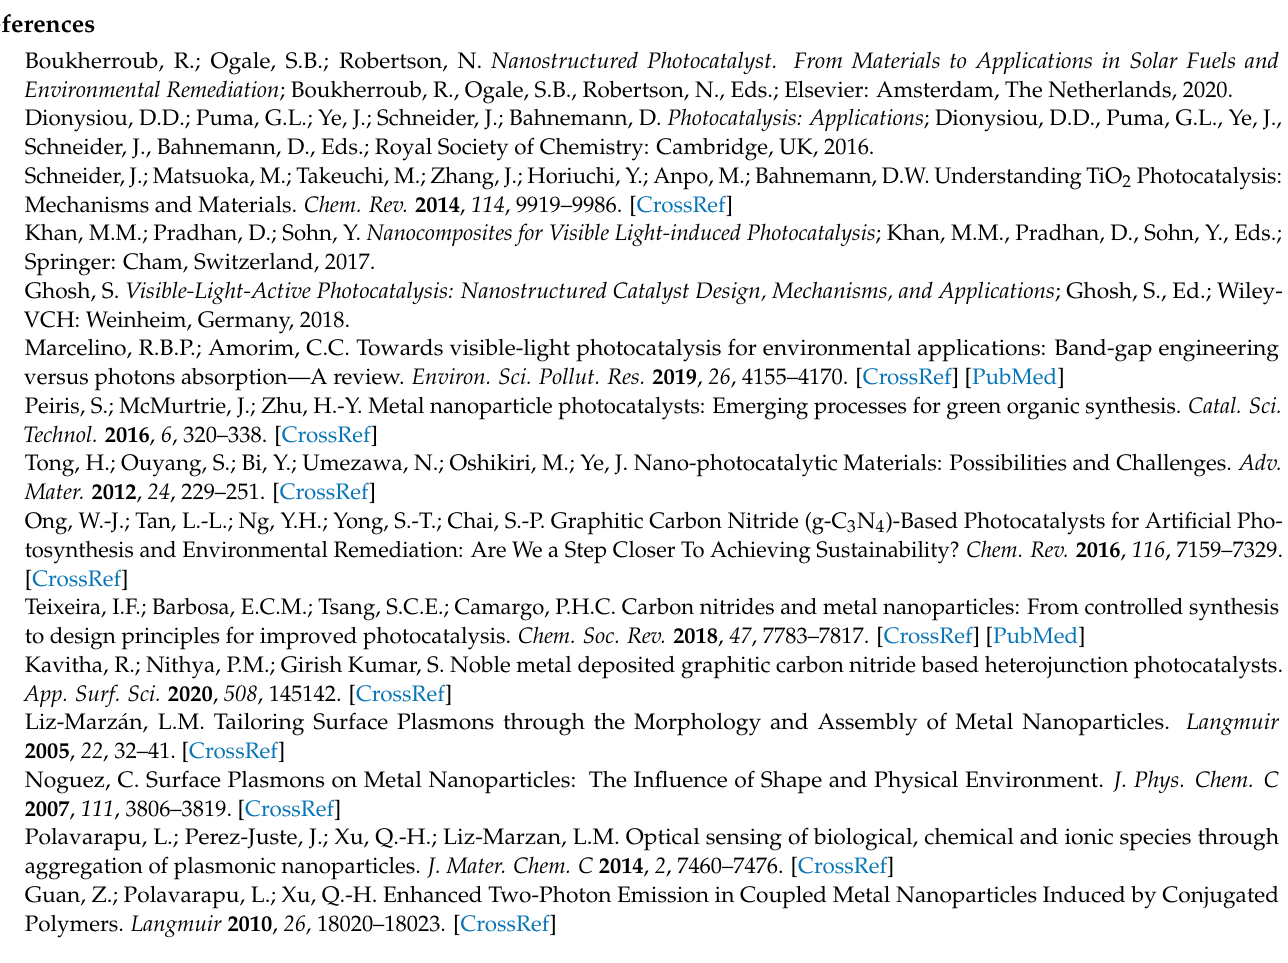
Figure S15. Kinetics of the photocatalysts 1 (left), 2 (center) and 3 (right) under visible light. The fitting results are represented assuming a pseudo-first order reaction, Figure S16. Kinetics of the photocatalysts 1 (left), and 3 (right) under sunlight. The fitting results are represented assuming a pseudo-first order reaction. Table S1. EDS analysis of AuAg NPs on nanohybrid 3 showing the wt% composition of Au, Ag and